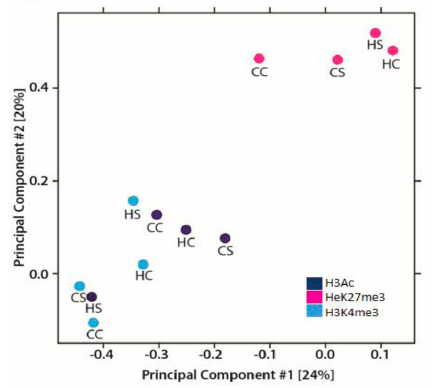
Figure 3. Differential histone modifications. Principal component analyses showing different profiles among three histone modifications (H3Ac, H3K4me3, and H3K27me3) and the four exposure groups. Axes showing % of variations. CC, controls; CS, diabetes exposed; HC, HF-diet exposed; HS, combination exposed.